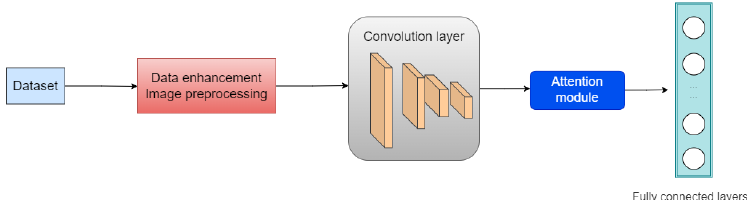
Figure 2. Feature extraction model.